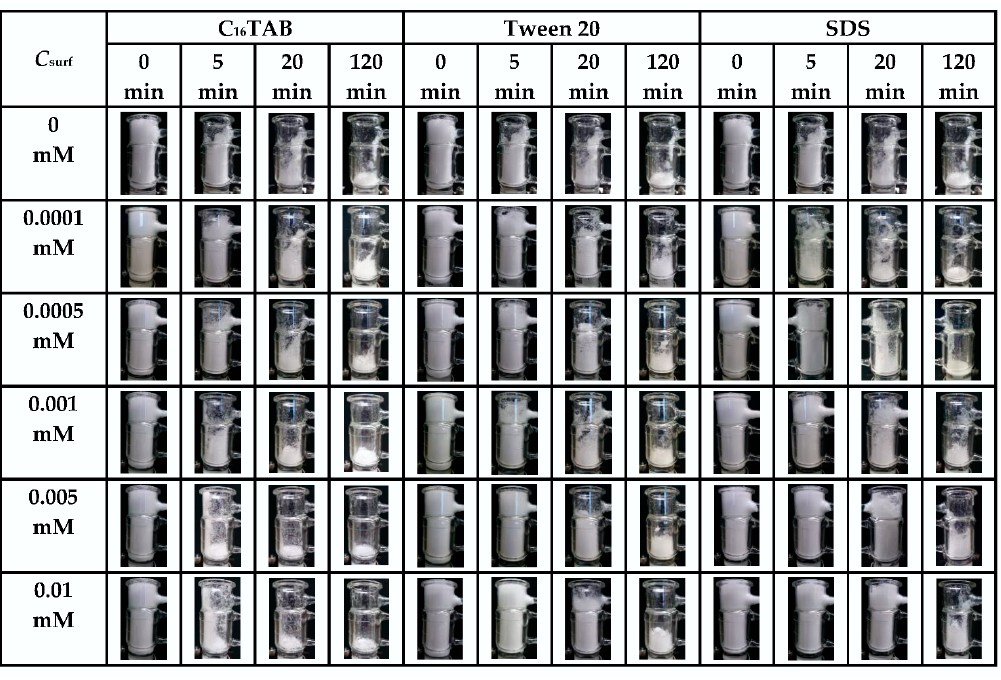
Figure 10. Digital photographs of foams generated from 0.2 mg/mL SF solutions in absence and presence of various types and amounts of surfactants taken at different times immediately after foam preparation (taken from